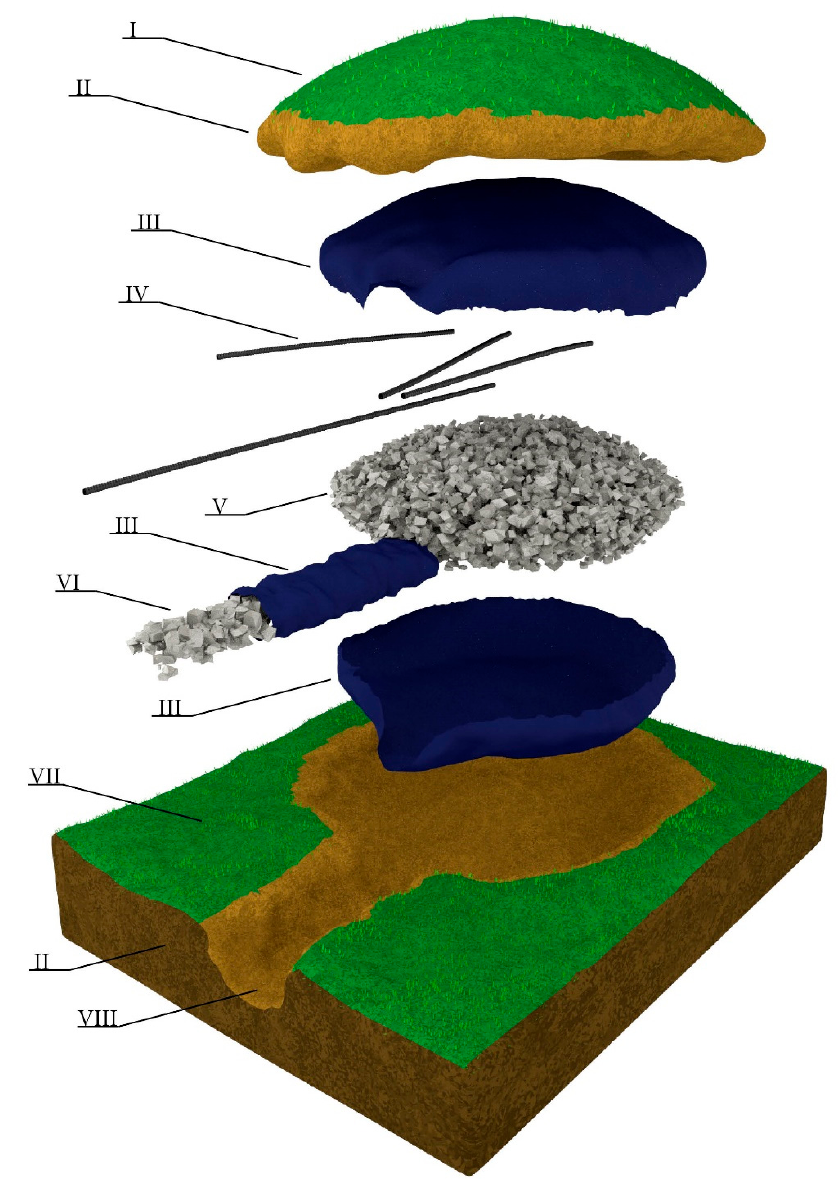
Figure A1. 3D model showing the different layers of Hotel 2. I & VII = vegetation, II = soil, III = geotextiles, IV = drainage pipes, V = stones 2–30 cm diameter, VI = rock-filled channel, VIII = drainage